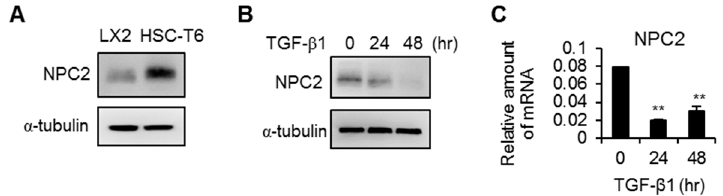
Figure 3. NPC2 is expressed in hepatic stellate cells (HSCs) and is down-regulated in activated HSCs. ( A ) Results from Western blot analyses of NPC2 expression in quiescent LX2 and HSC-T6 cells; ( B , C ) Western blot ( B ) and Q-PCR ( C ) analyses of NPC2 expression in LX2 cells treated with 20 ng/mL transforming growth factor- β 1 (TGF- β 1). Data are expressed as mean ± SD. ** p < 0.01 vs. time 0.